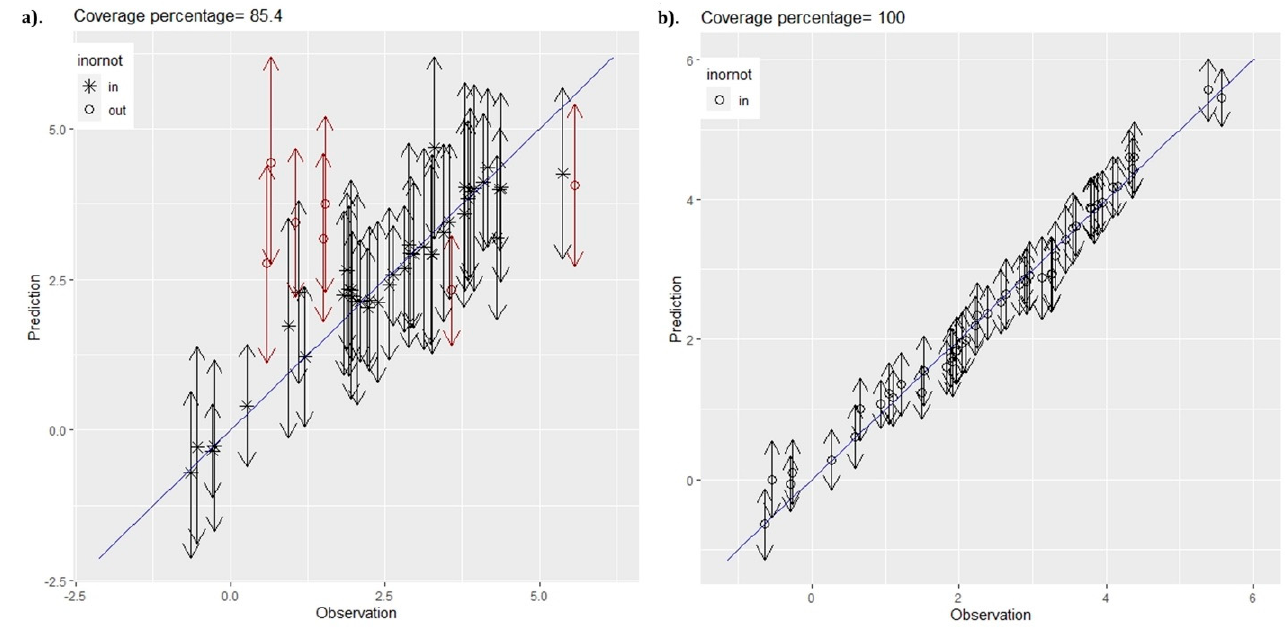
Figure 5. ( a ) Predictions (MgC ha − 1 ) against observed C stock (MgCha − 1 ) for the Landsat-8-based spatial model. ( b ) Predictions against observed C stock for the Sentinel-2-based spatial model alongside 95% intervals. Table 3. Validation statistics for C stock Bayesian-based C stock predictive